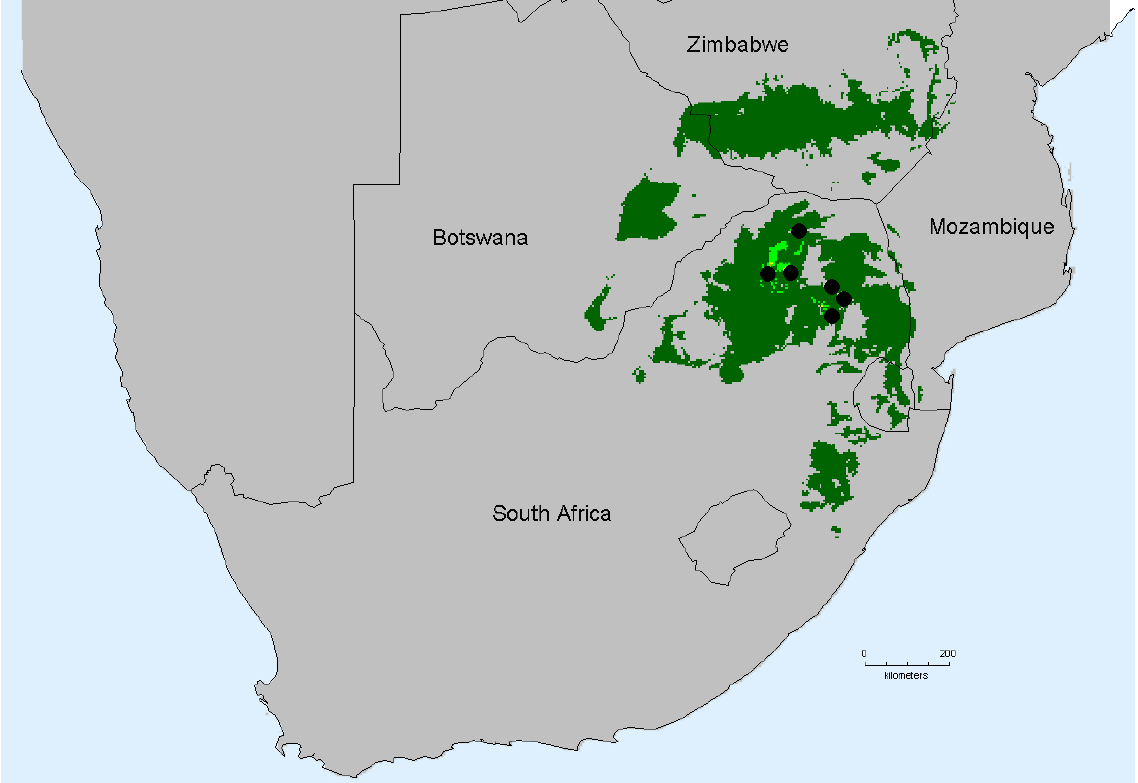
Fig. 15. Predicted distribution of Ballomma gen. nov. calculated in dIVA-GIS on the base of all climatic data as default in the software. Black dots present known localities of Balloma gen. nov. dark green areas have expected occurrence with the 5–95 percentile; pale green with 2.5–97.5